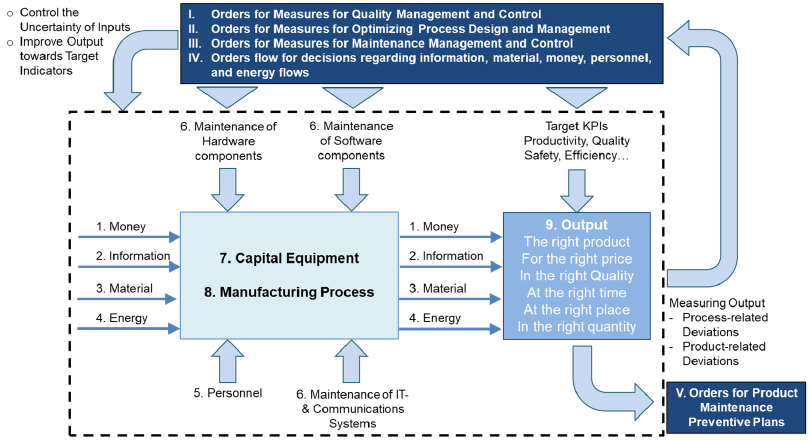
Figure 1. Diagram of the manufacturing process of input–output: areas and flows including decisions/orders (own elaboration).